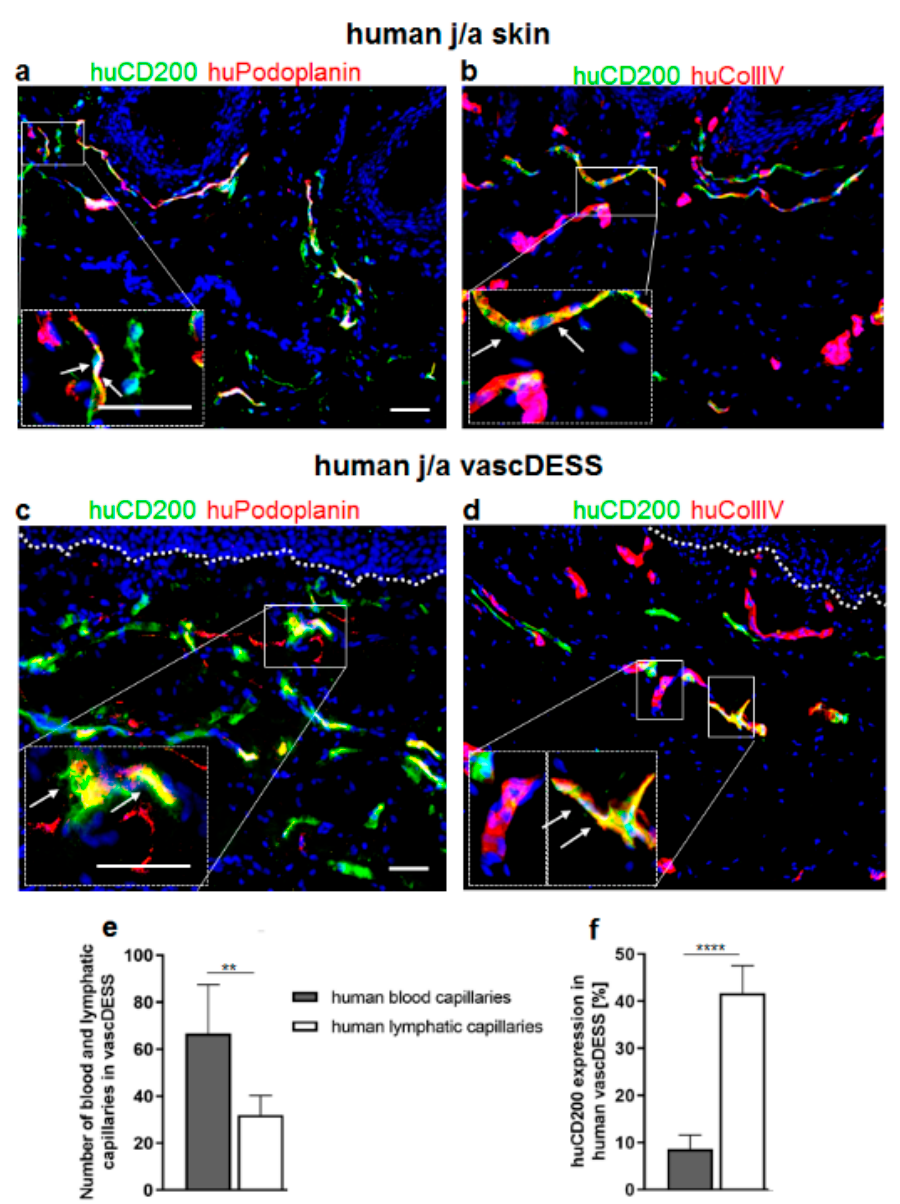
Figure 7. Quantification of CD200 expression in transplanted vascDESS. ( a , b ) Immunofluorescence co-staining of j/a human skin against huCD200 (green) and huPodoplanin ( a ) or collagen IV ( b ). Podoplanin depicts human lymphatic endothelium, while collagen IV is expressed exclusively around human blood capillaries. White arrows in magnification insets indicate double-positive microvascular structures. ( c , d ) Immunoflorescence co-staining of vascDESS against huCD200 (green) as well as huPodoplanin (red), visualizing the human lymphatic capillaries ( c ) and huCollagen IV (red) depicting the human blood endothelium ( d ). ( e ) Quantification revealed that vascDESS contains a significantly higher number of blood (66.59 ± 20.95) than lymphatic capillaries (32 ± 8.34; ** p = 0.009). Presented values are the mean ( ± SD) of total numbers of human CD31 + or podoplanin + vessels counted per 10 × high-power field, n = 6 biological samples in each group. White arrows in magnification insets indicate double-positive microvascular structures. ( f ) Quantification of CD200 expression on blood and lymphatic vessels in vascDESS. Please note that CD200 is expressed mainly on the lymphatic vessels (41.67 ± 5.89), while blood vessels exhibit only minor expression of that marker (8.63 ± 2.95; **** p < 0.0001). The results are expressed as mean ± SD from n = 3 biological donors from 3 independent animal transplantation (6 animals in total). Cell nuclei are stained with Hoechst (blue). Scale bars 50 µ